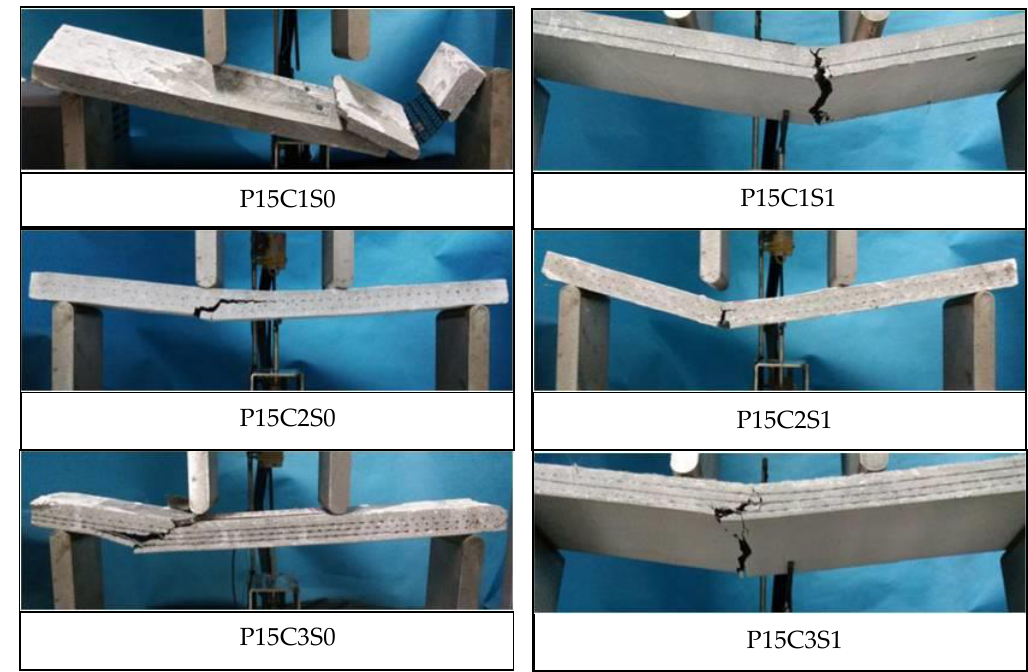
Figure 23. Failure modes of the prestressed TRC specimens.